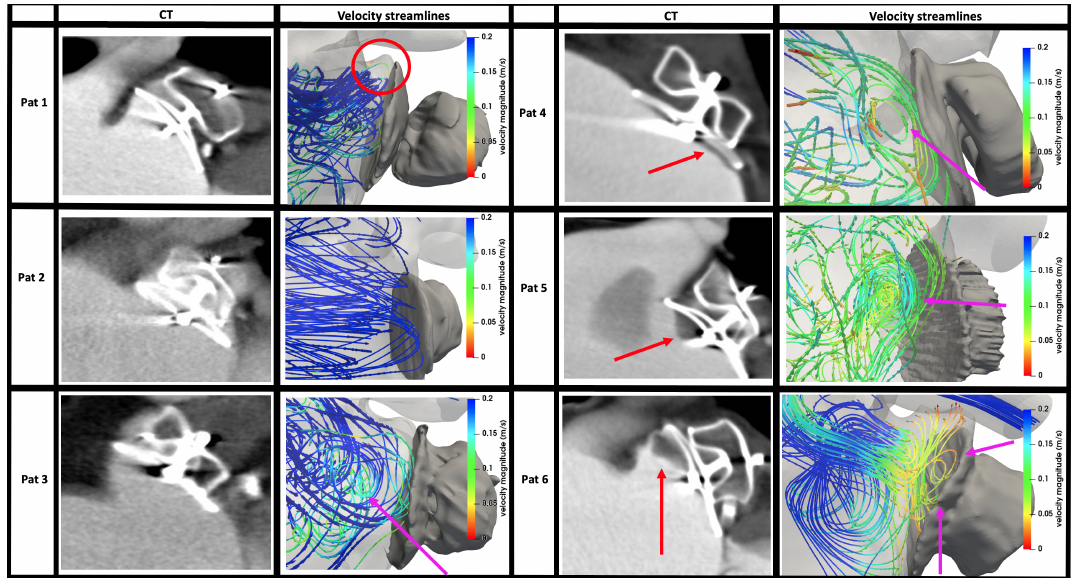
Figure 6. Computed tomography (CT) scans after left atrial appendage implantation for cases with (Pat 4–6) and without (Pat 1–3) device-related thrombus together with streamline-based visualisation of the simulated blood flow patterns, coloured by velocity magnitude (blue and red corresponding to high and low values, respectively). Red arrows in CT scans indicate where the thrombus was found. Pink arrows in the velocity streamline plots indicate flow recirculations or flow stagnation patterns (independently of velocity magnitude); the red circle indicates the pulmonary ridge (PR). Although Pat 1 had an uncovered PR, the velocities in the area were relatively high, reducing the risk of thrombus